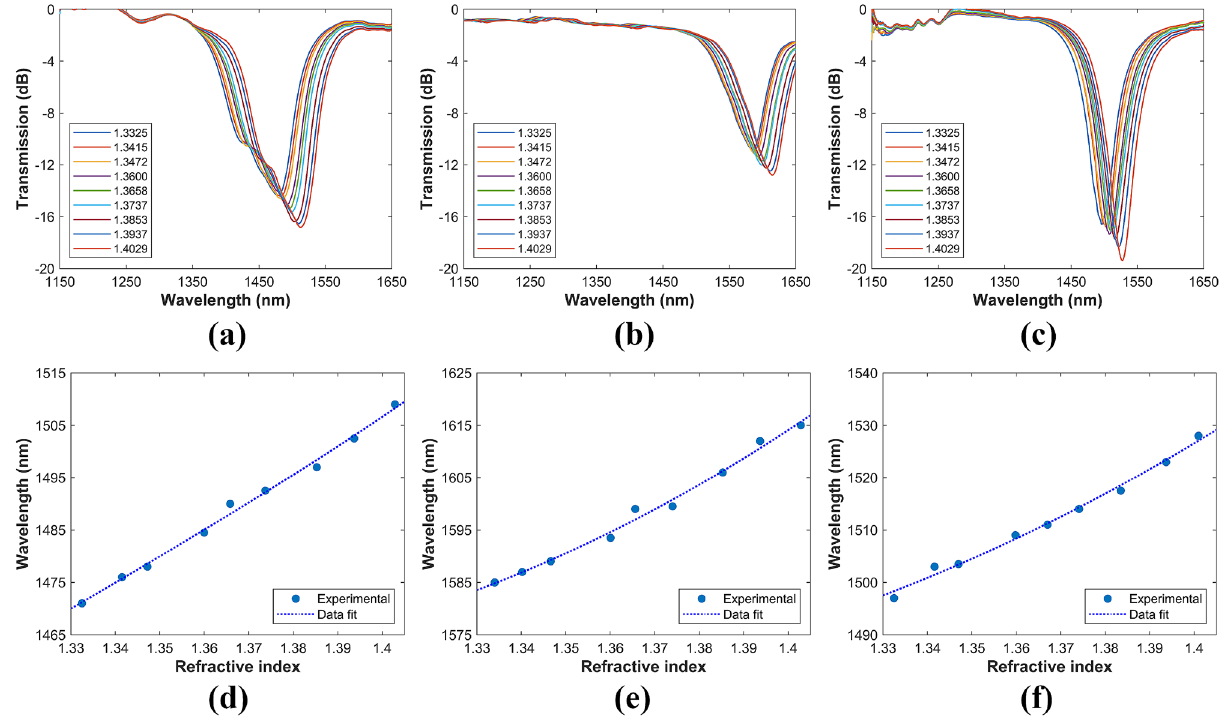
Figure 5. Characterization of the devices as refractometers. Experimental transmission spectra as function of the surrounding RI: ( a ) 3-layer, ( b ) 5-layer, and ( c ) 6-layer 1DPC. Evolution of the corresponding central wavelengths of the attenuation peaks: ( d ) 3-layer, ( e ) 5-layer and, ( f ) 6-layer 1DPC.